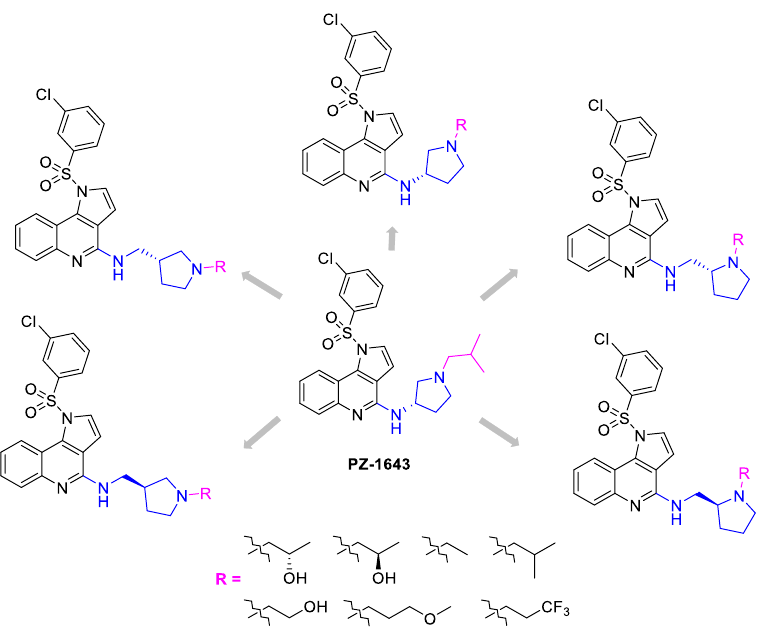
Figure 2. Structural modifications in the amine fragment of novel 1 H -pyrrolo[3,2- c ]quinoline deriv- atives.